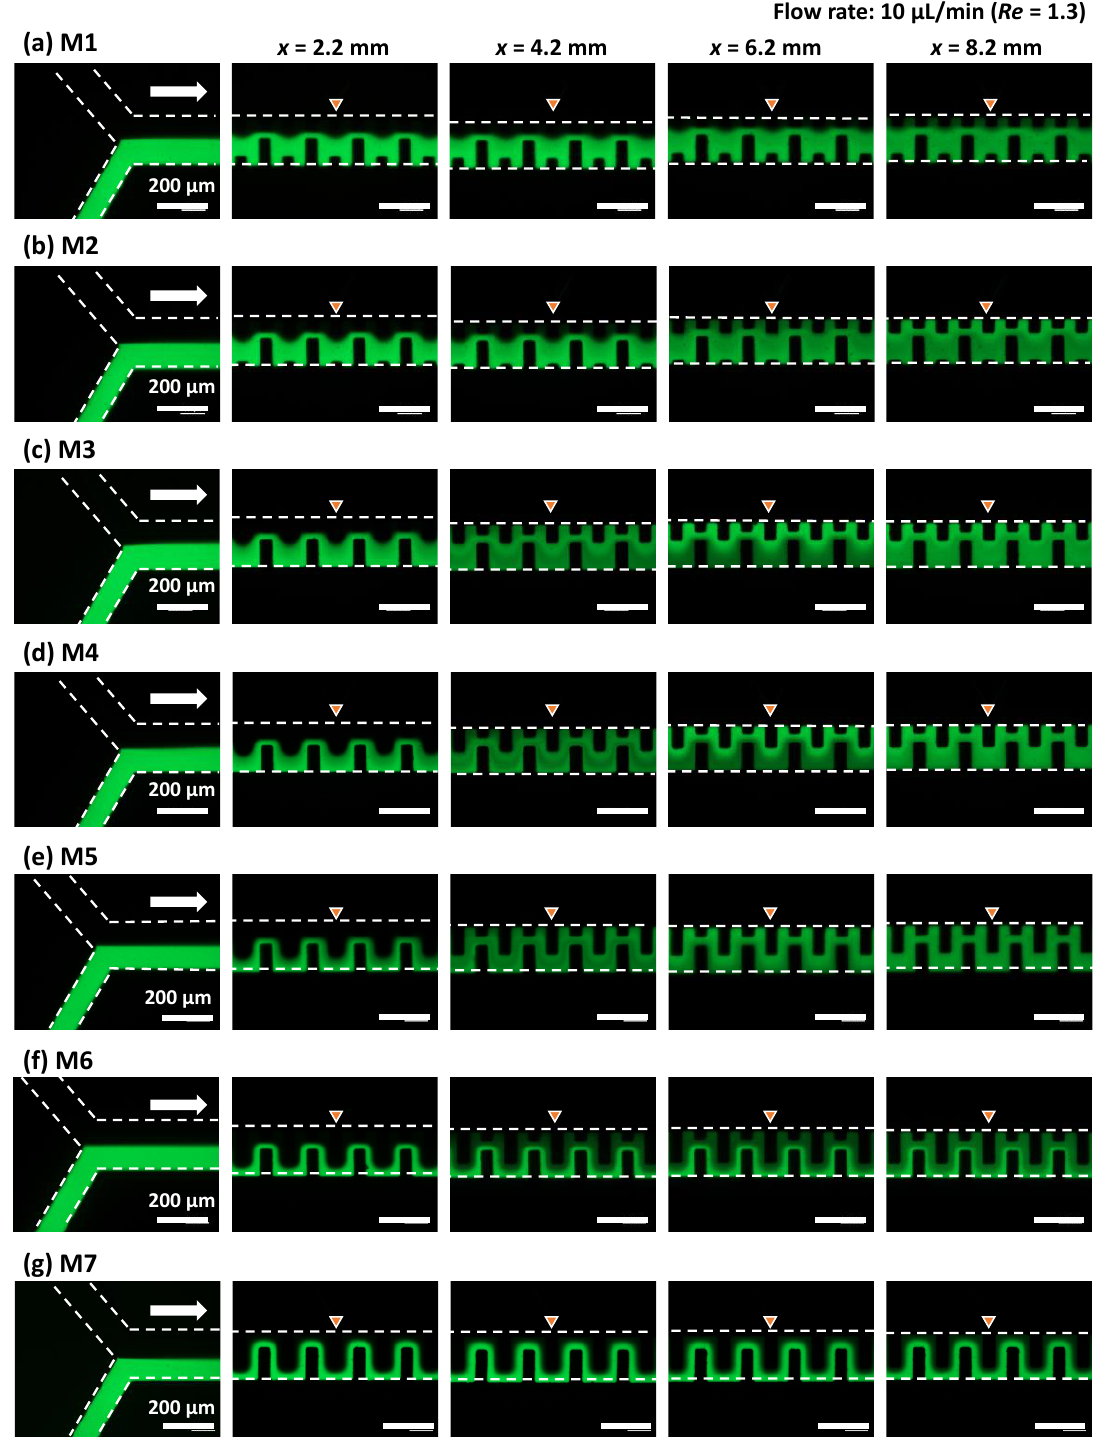
Figure 8. Experimental investigation of the mixing behaviors of ( a – f ) six different types of asymmetric micromixers (M1–M6) and ( g ) the serpentine micromixer (M7) with a perfectly symmetric mixing unit. Pure water and fluorescein-dyed water (0.1 mol/m 3 ) were introduced at the same flow rate of 5 µL/min (a total flow rate of 10 µL/min and Re = 1.3).